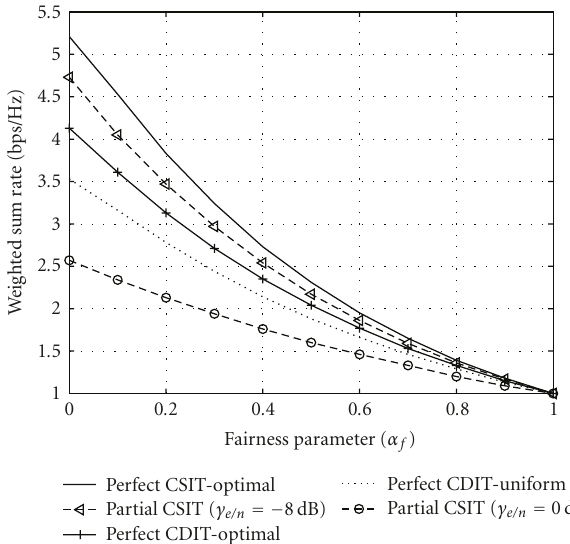
Figure 3: Tradeo ff between maximized weighted-sum rate and fairness requirement for di ff erent resource allocation schemes and mean SNR of 15